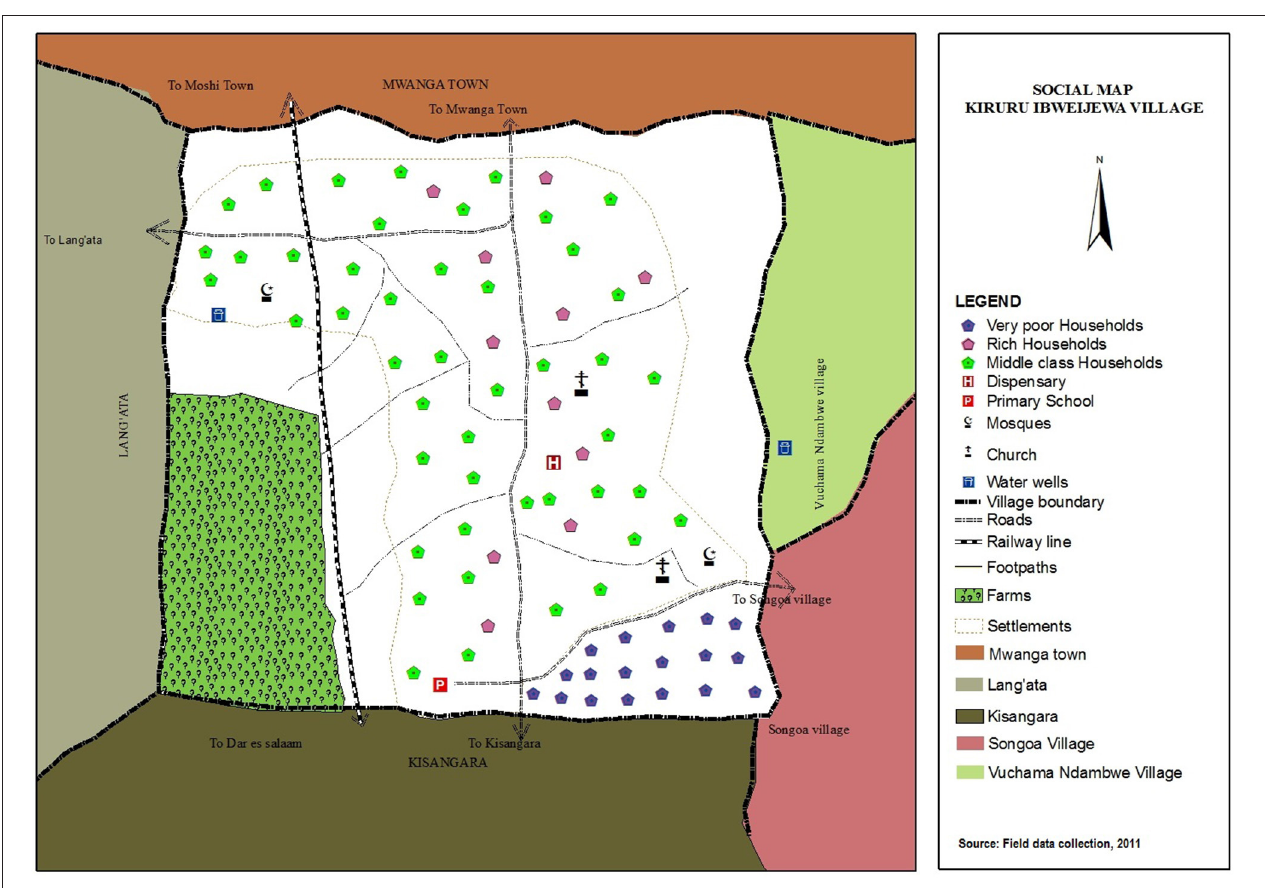
FIGURE 3 | Social map of Kiruruibwajewa Village, Mwanga